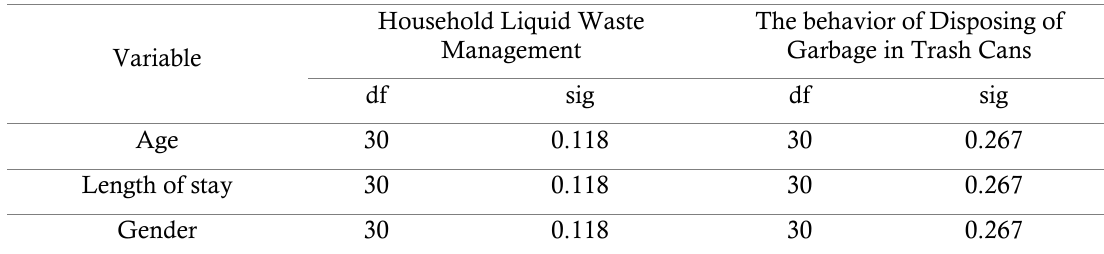
Table 3 Results of the Shapiro-Wilk Test on Household Effluent Management Behavior